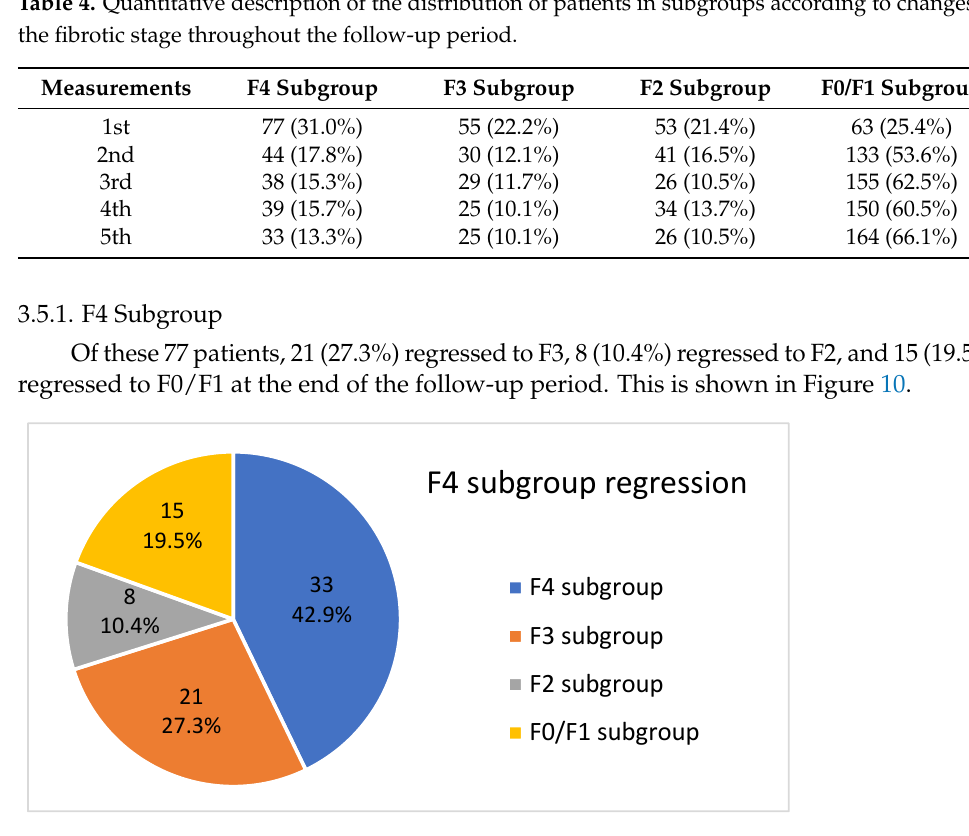
Table 4. Quantitative description of the distribution of patients in subgroups according to changes in the fibrotic stage throughout the follow-up period.